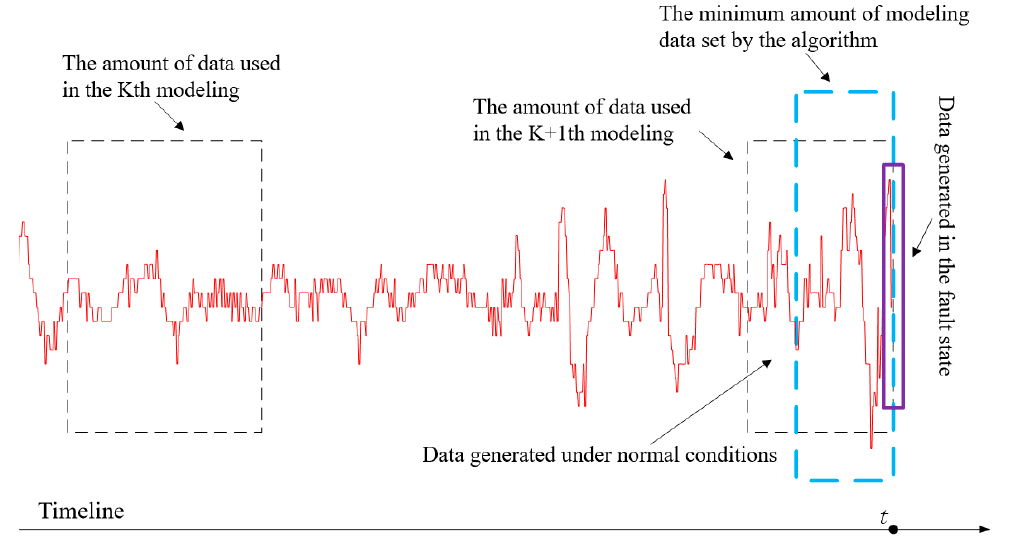
Figure 5. Modeling data in fault conditions.